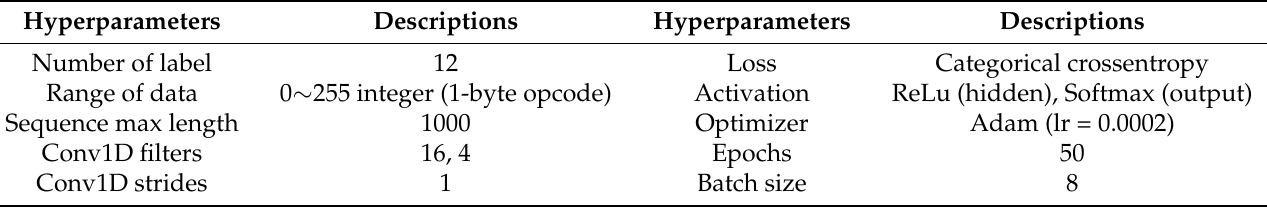
Table 2. The hyperparameters for